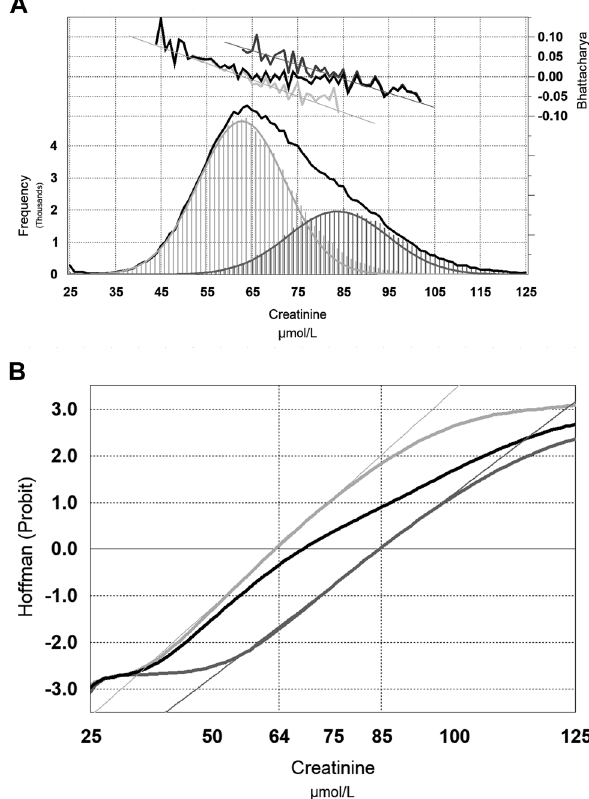
Figure 4: Hypothetical distribution of serumcreatinine in men (dark grey), women (light grey) and the combined distribution of men and women (black line). function (see text for further explanation).